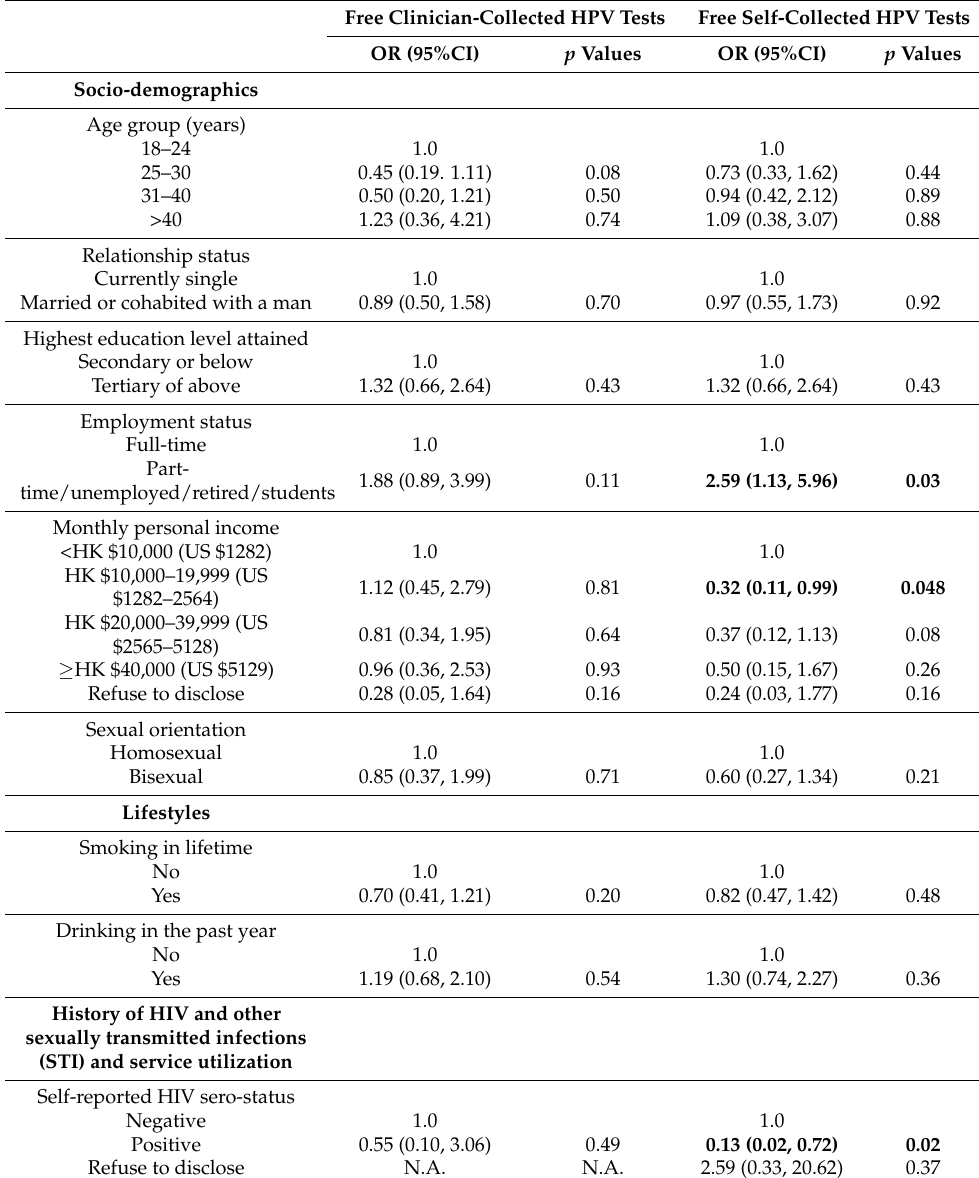
Table 3. Associations between background characteristics and behavioral intention to take up free clinician-collected and self-collected HPV tests ( n =